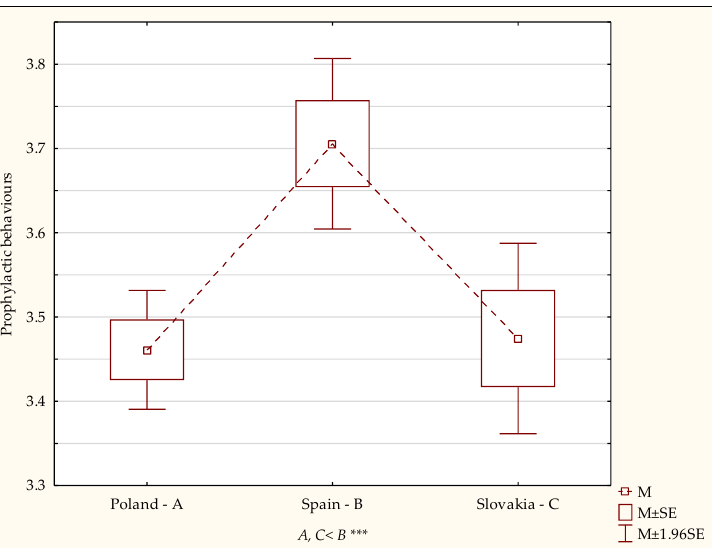
Figure 2. Intensity of prophylactic behaviours—diversity of scores. Statistically significant: *** p < 0.001 .